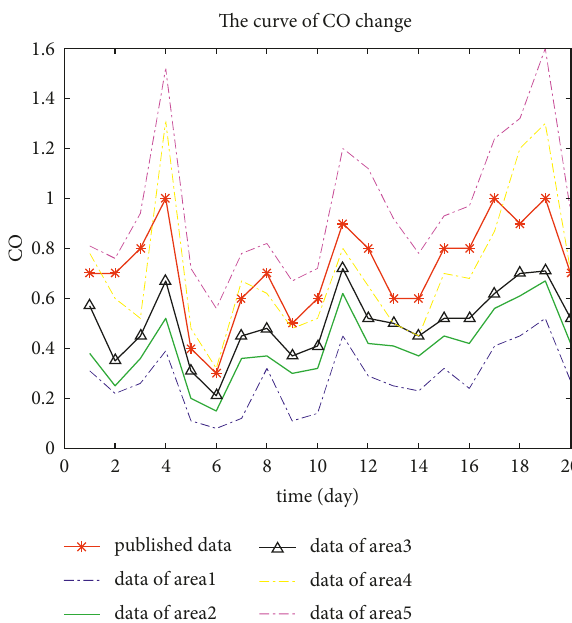
Figure 6: Curve of PM10 change in different task grid areas.